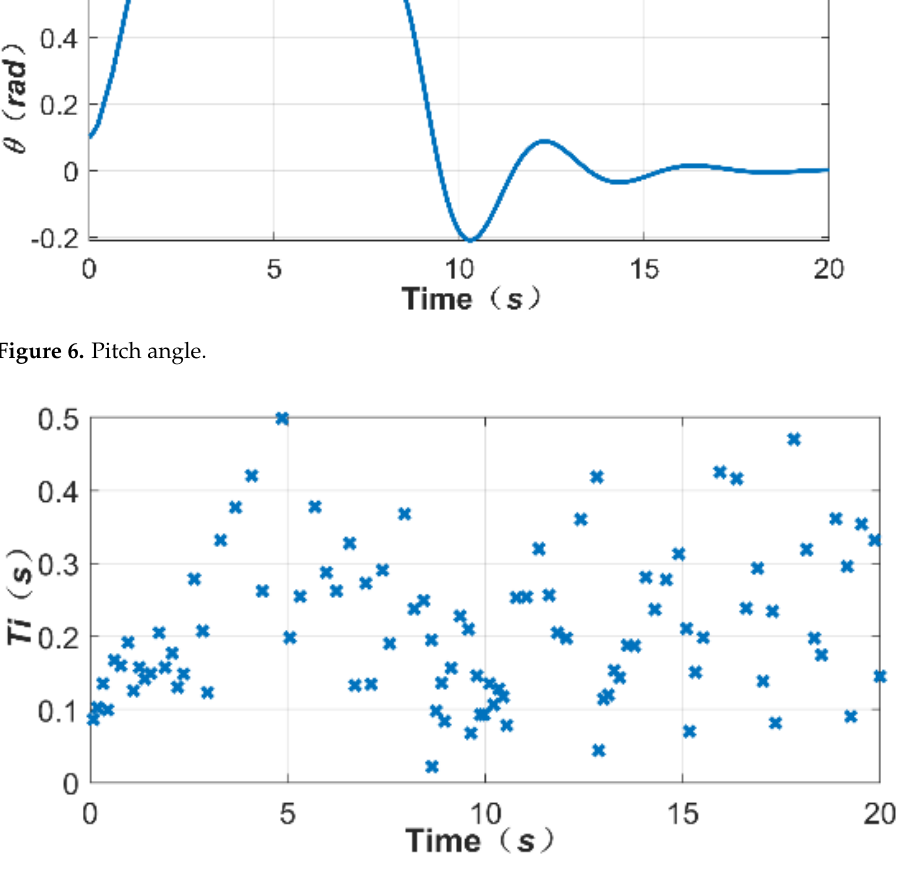
Figure 7. The event-triggered interval.